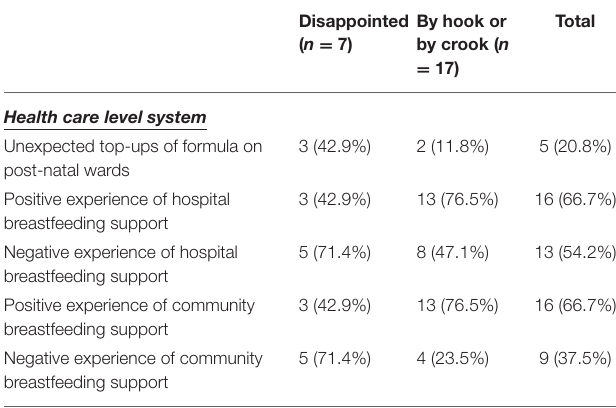
TABLE 3 | Different system level key factors by feeding